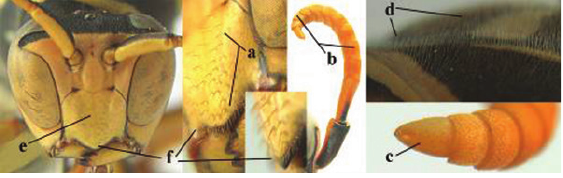
27 Most of clypeus with long bristles and distinct punctures (a); apical half of antenna uniformly orange-yellow dorsally and ventrally (b); apical antennal segment com- paratively stout and dorsally about 1.5 times as long as wide basally (c); setae of pro- notum medio-dorsally and of mesoscutum about half as long as width of posterior ocellus (d); width of clypeus 1.1 times its length (e) and medio-ventrally more flat- tened (f); [fourth and fifth antennal segments strongly oblique in lateral view]; Eu- rope (for specimens from Crete see also P. bucharensis ), NW Africa, W and C Turkey, Azerbaijan, probably more eastern in temperate Asia .... P. dominula (Christ,